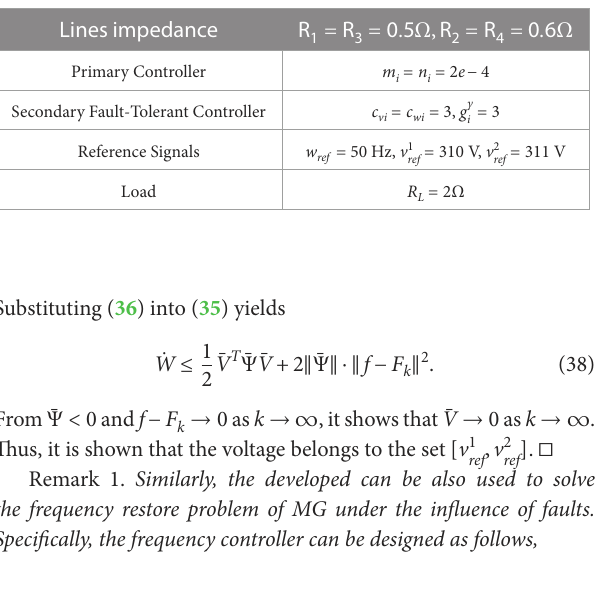
TABLE1 TheACMGparametersandthefault-tolerantcontroller parameters.